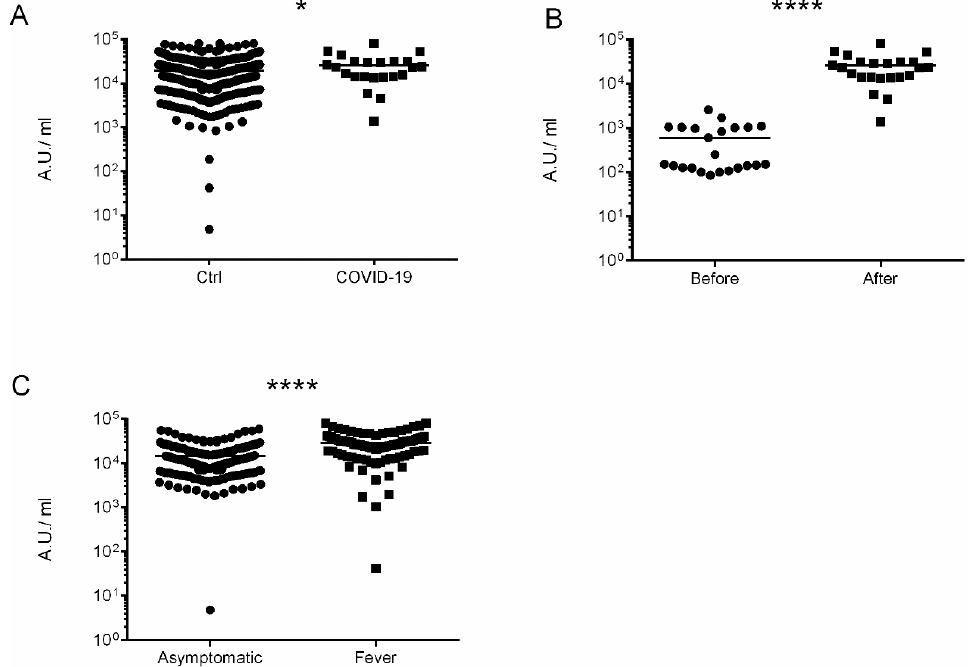
Figure 1. The immunogenic effect of mRNA vaccine. ( A ) Levels of antibodies after vaccination. Comparison of controls vs. COVID-19 patients. ( B ) Levels of antibodies in COVID-19 patients before and after vaccination. ( C ) Levels of antibodies after vaccination in asymptomatic persons vs. systemic adverse events (fever) persons. The date is presented as log10. * p = 0.049 and **** p < 0.0001.